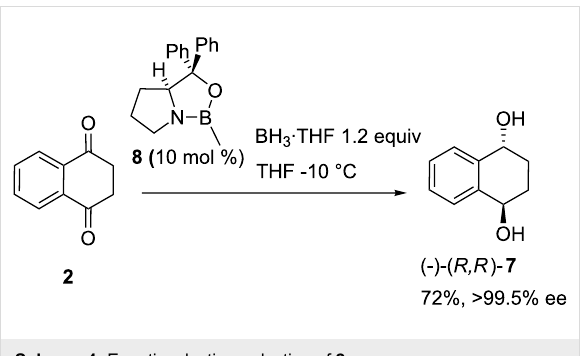
Scheme 3: Proposed origin of diastereomeric preference in the reduction of 2 .